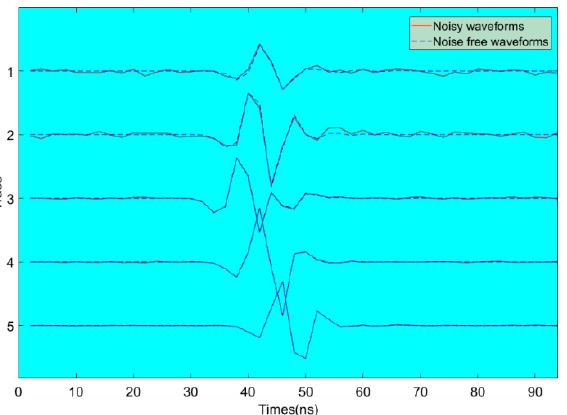
Figure 3. Noise-free waveforms and noisy waveforms: the signal-to-noise ratios from the top are 8, 15, 24, 32 and 40, respectively.